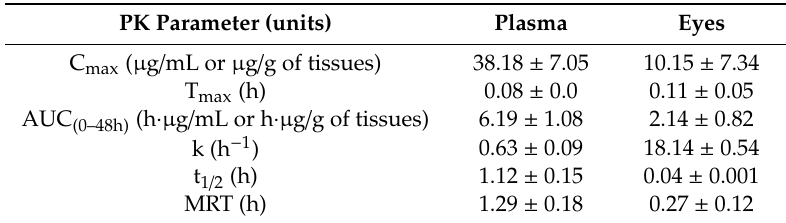
Table 4. The pharmacokinetic parameter values of mice plasma and eyes after oral administration of YSB201 (125 mg / kg) ( n = 3).